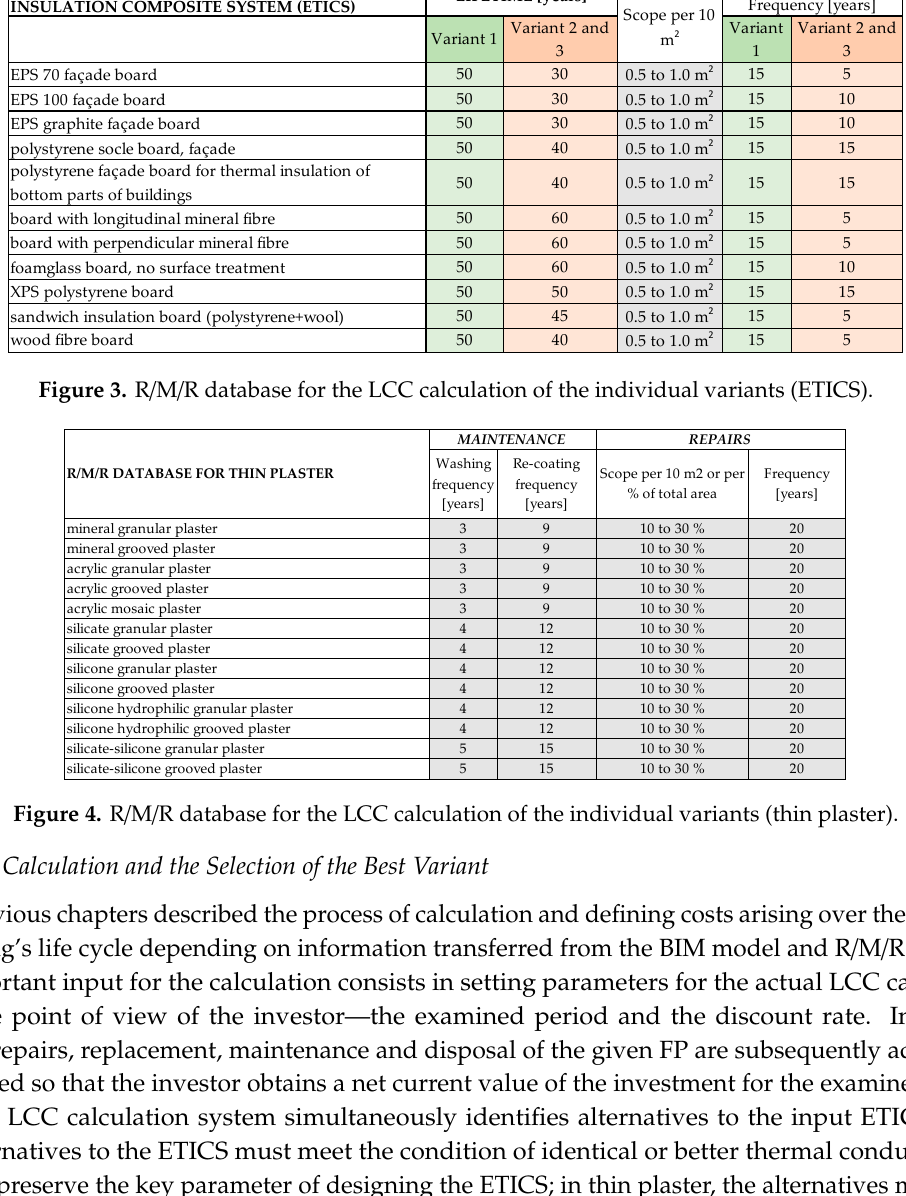
Figure 5. Output of the LCC calculation for Variant 1.